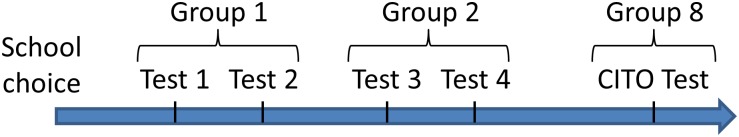
Timeline of the conducted tests in preschool.
Note: Tests 1 was taken in January 2007. Test 2 was taken in May or June 2007. Test 3 was taken in January 2008, and Test 4 was taken in May or June 2008. Tests one and two contain the same questions. Tests three and four also contain the same items. Children had, on average, six months of schooling when taking the first test. The average time that elapsed between the first two tests in grade one of preschool is 4.3 months, and 3.9 months passed between tests three and four in grade two of preschool. The average time that passed between tests one and four is 16.3 months.